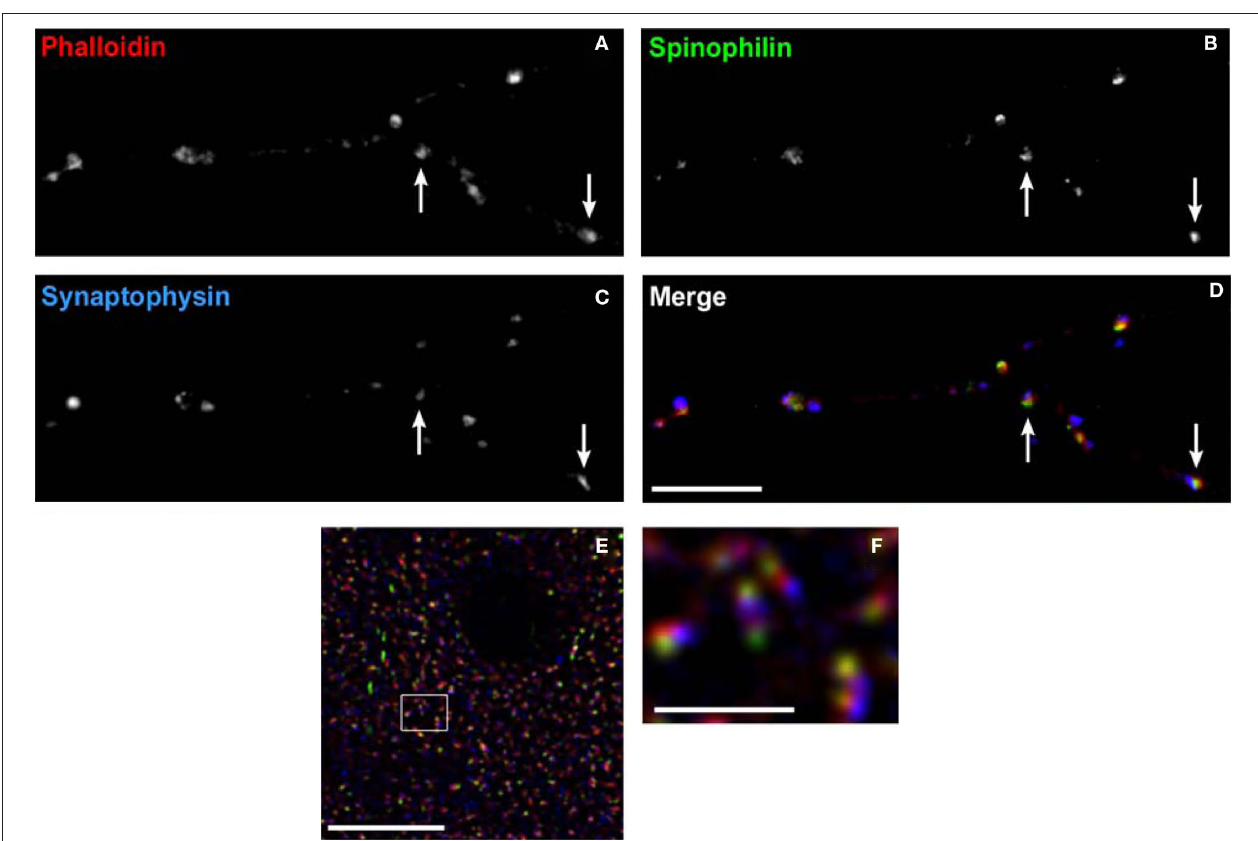
F-actin binding toxin phalloidin (red), immunoreactivity to synaptopodin (green), and to spinophilin (blue) within dendritic spines in monkey cortex. (F) Higher power view of (e) Note the ability to resolve spine subcompartments, with phalloidin in the spine head, synaptopodin at the spine apparatus, and spinophilin at the post-synaptic density. Bar in (A) , (e) = 10 μm, in bar (F) = 2